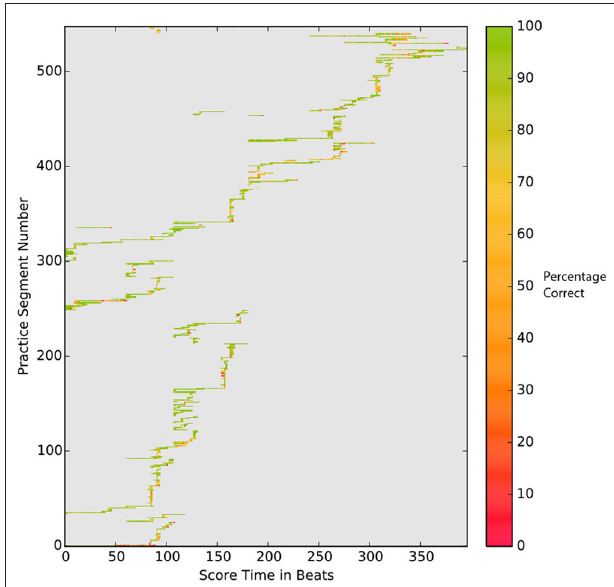
FIGURE 5 | Practice Session Precision Map for expert player (E-1). Graph shows coverage for each beat; the color marks note accuracy beat (% correct) within each beat.